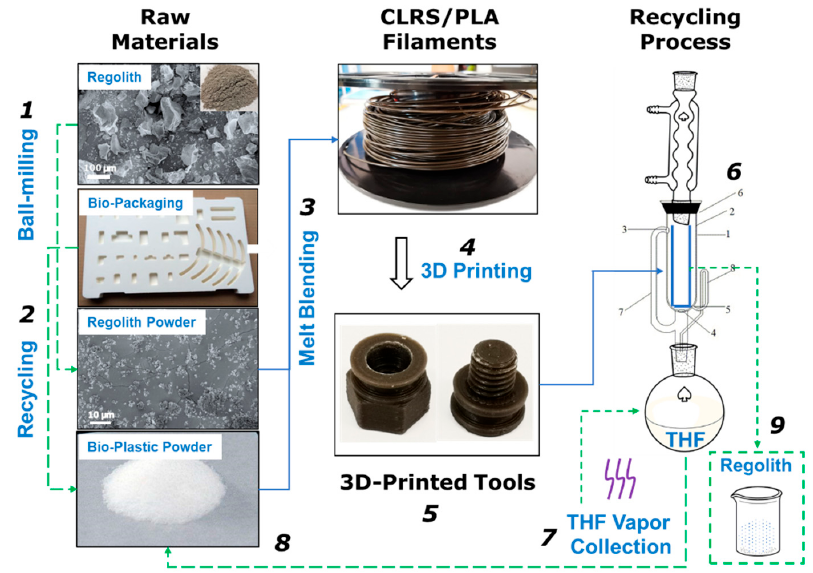
Figure 10. Schematic diagram of the fabrication and recycling of the component, lunar regolith ball milling ( 1 ), PLA recycling ( 2 ), raw material regolith and PLA melt blending, extrusion ( 3 ), 3D printing ( 4 ), final 3D printed tools ( 5 ), recycling process ( 6 ), tetrahydrofuran (THF) vapor collection ( 7 ), recycled PLA ( 8 ), recycled regolith ( 9